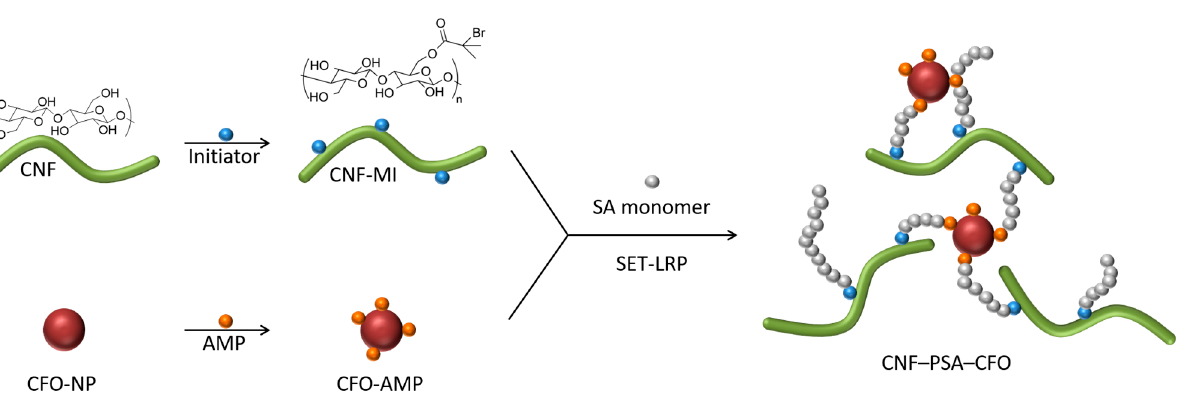
with 2 ‐ bromo ‐ 2 ‐ methylpropionic acid [24].